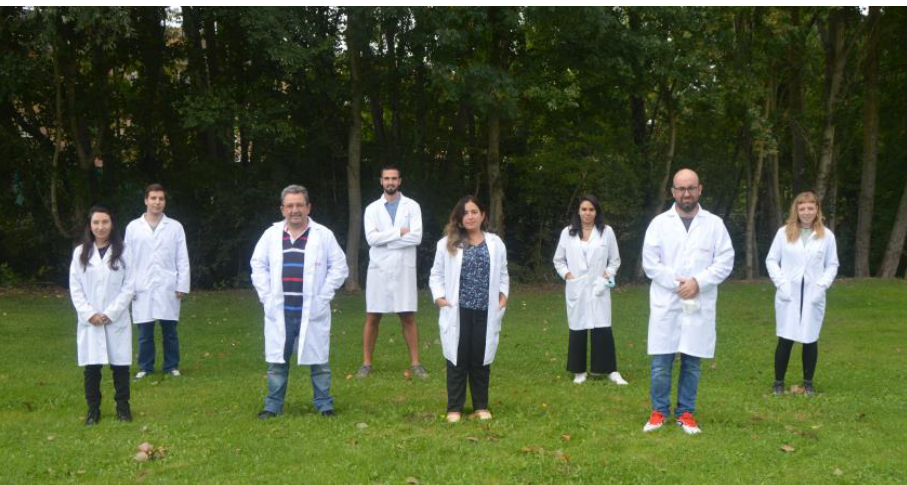
Figure 1. Research group of “Sustainable Agriculture and Biomonitoring” at the